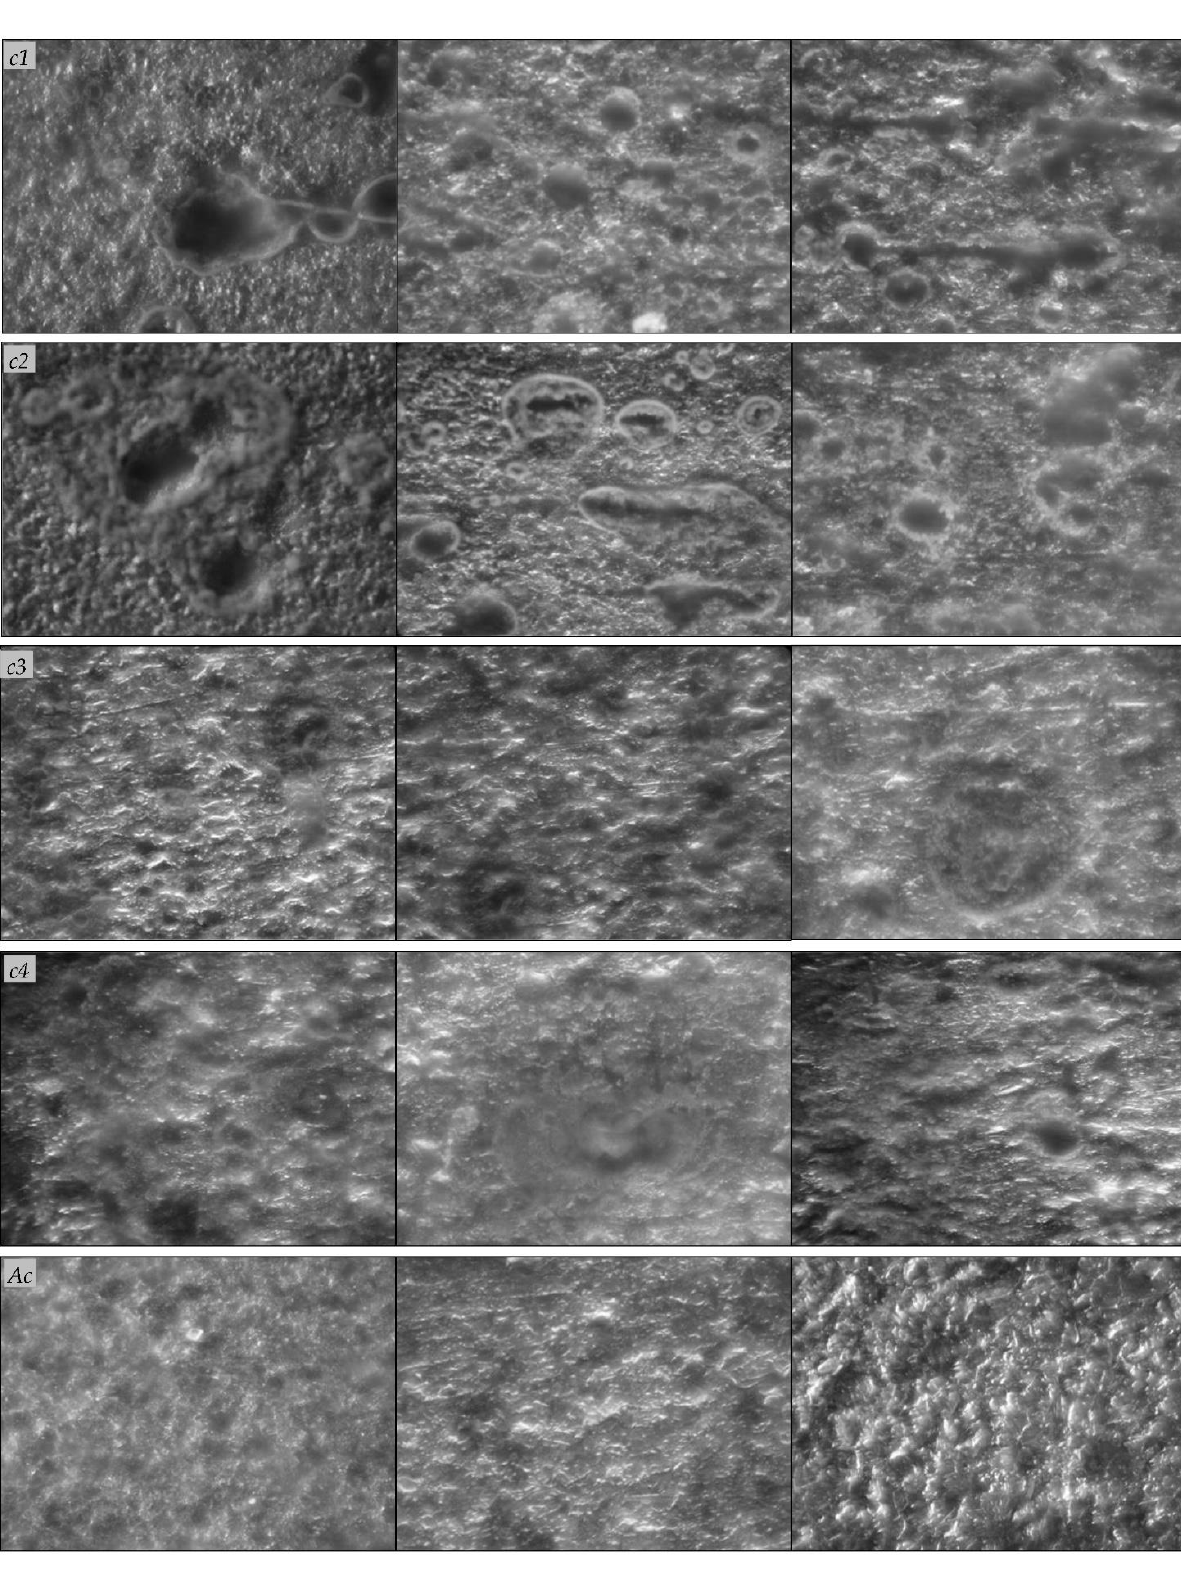
Figure 5. Optical microscopy observation of carbon steel coupons after the removal of biofilm and corrosion products. Carbon steel A570 ( c1 , c2 ), 1045 ( c3 , c4 ) coupons immersed in the water sample and incubated for 120 days under aerobic ( c1 , c3 ) or anaerobic ( c2 , c4 ) conditions; abiotic controls ( Ac ); magnification of ×40.